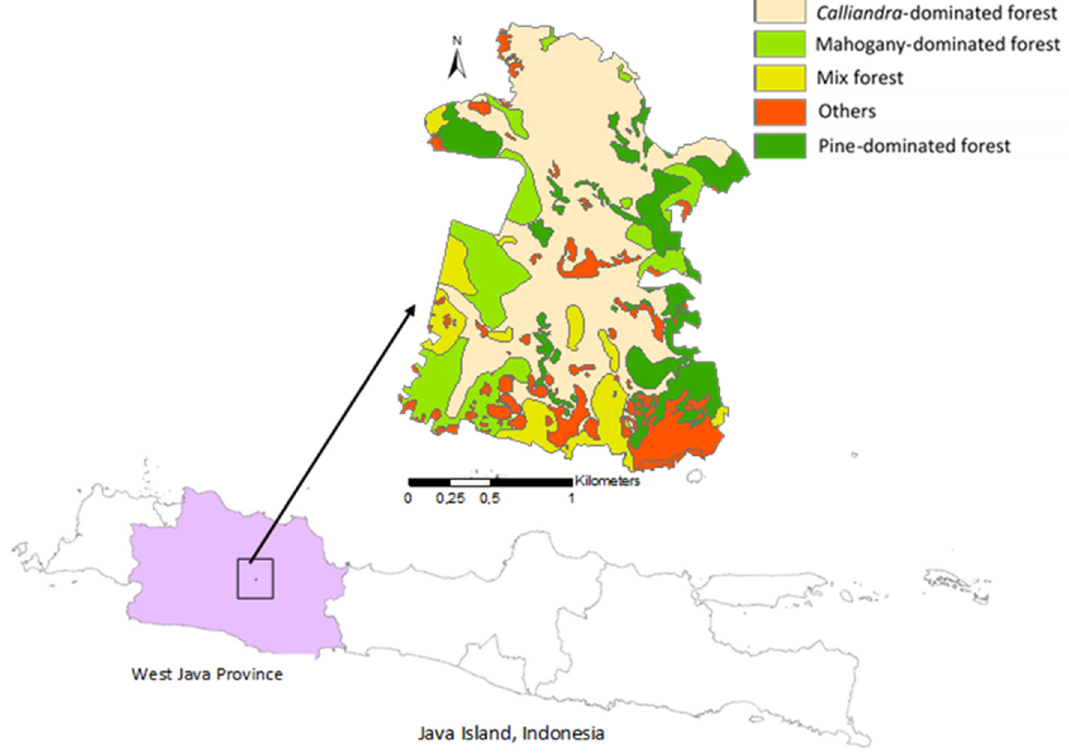
Figure 1. Geographical location and land-cover types of the Geulis Mountain forest.